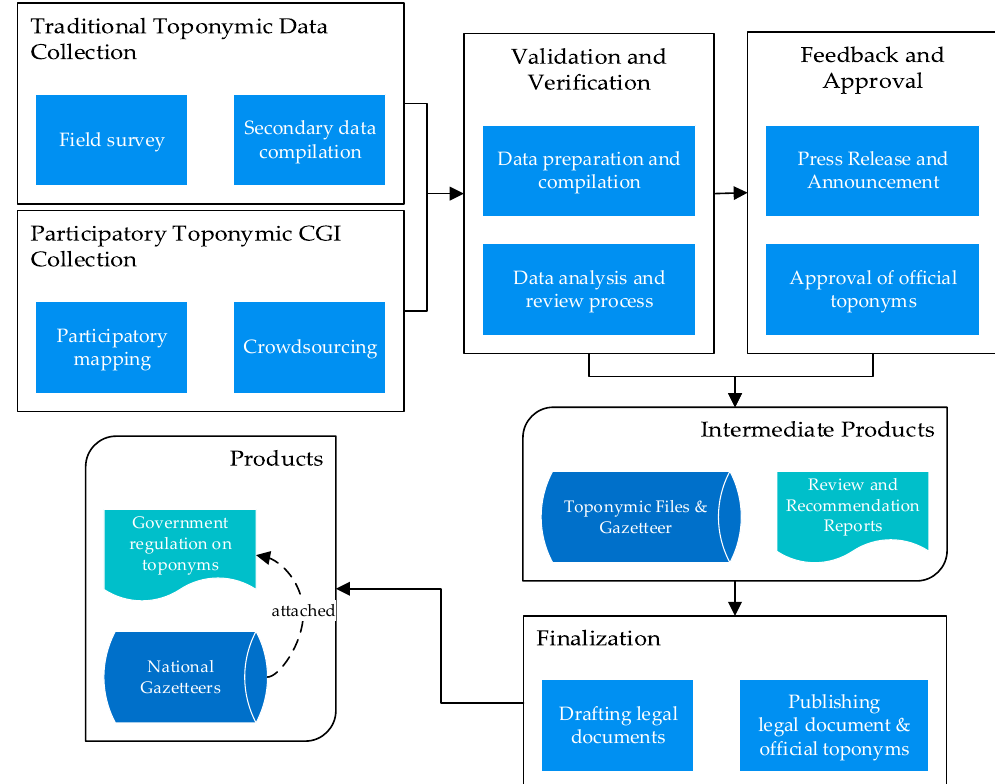
Figure 5. Proposal of toponym handling in a draft government regulation on toponyms in Indonesia (modified from BIG, 2019).